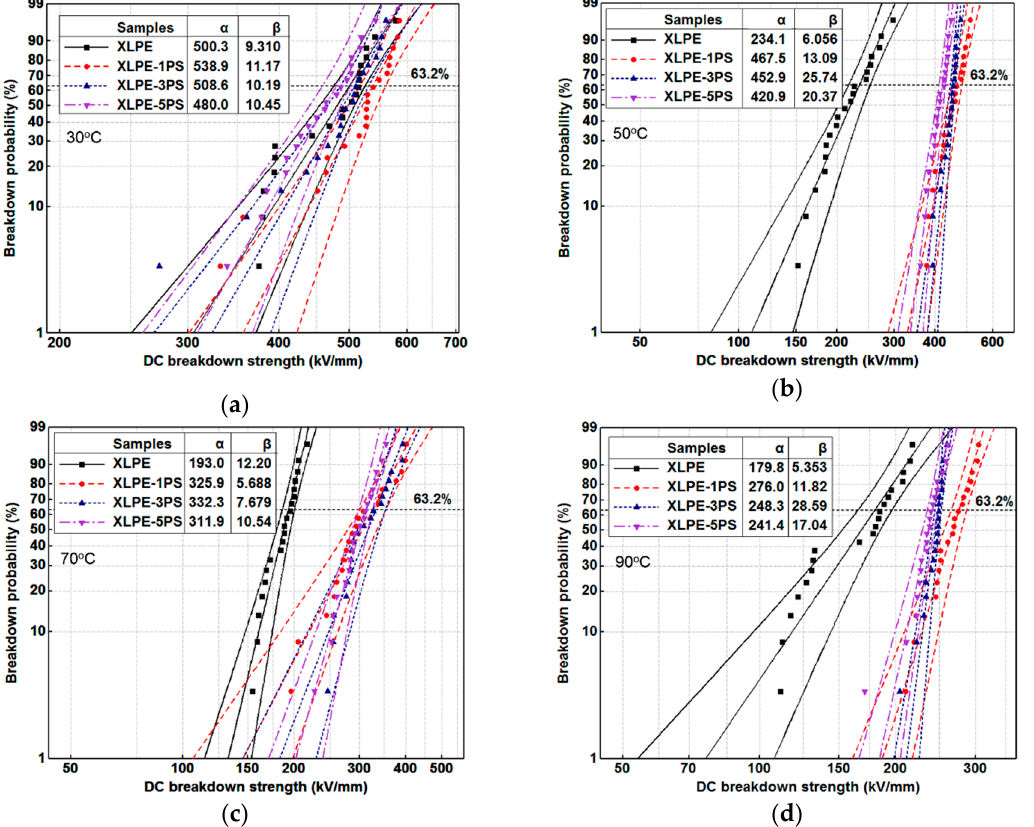
Figure 3. Weibull distribution of DC breakdown strength for samples under different temperatures, ( a ) 30 °C; ( b ) 50 °C; ( c ) 70 °C; ( d ) 90 °C.